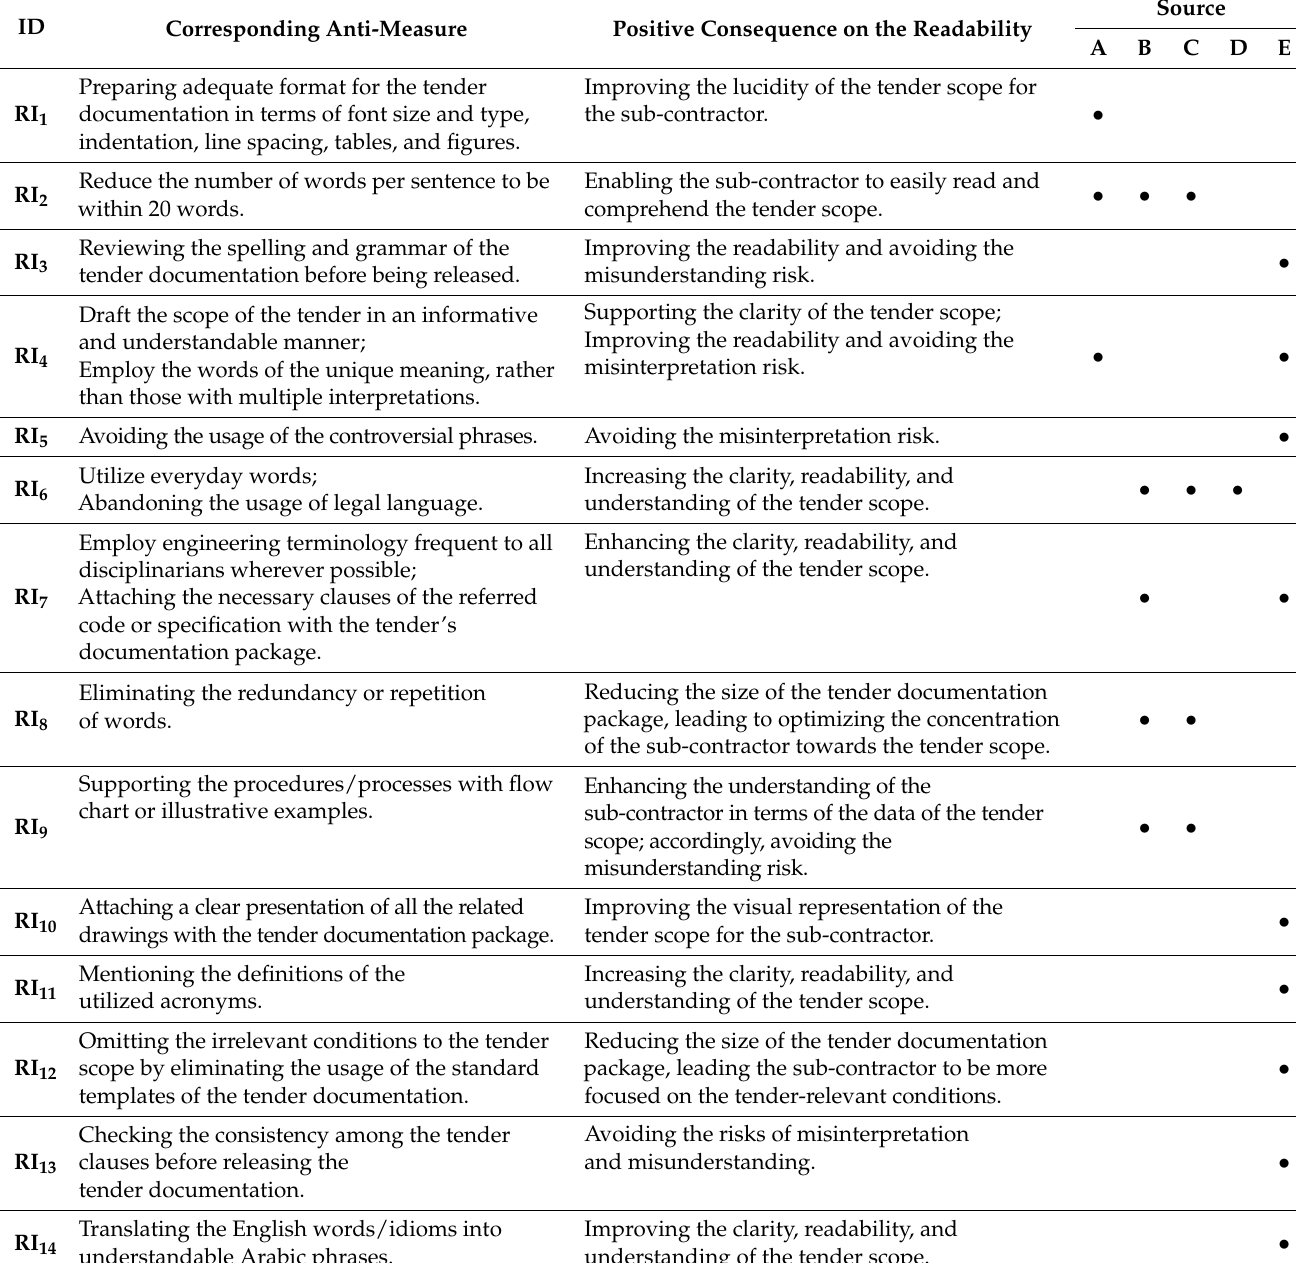
Table 5. Anti-measures of the readability